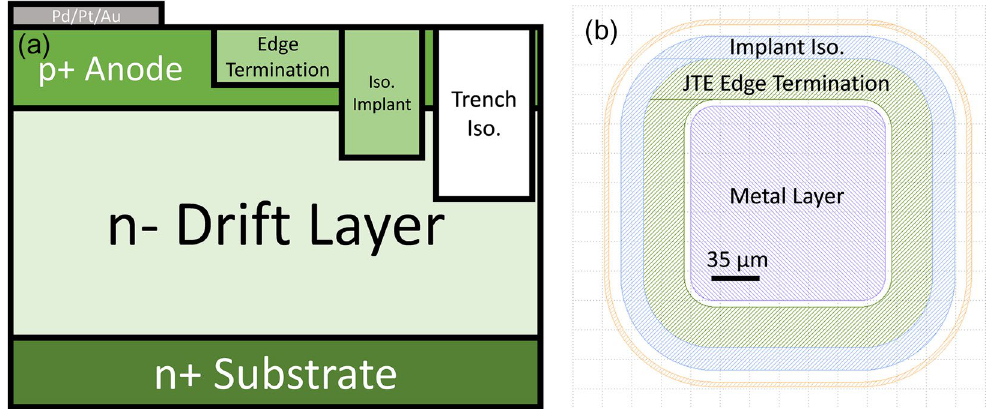
Figure 1. Side view ( a ) and top view ( b ) diagrams of the vertical PN diodes fabricated for this